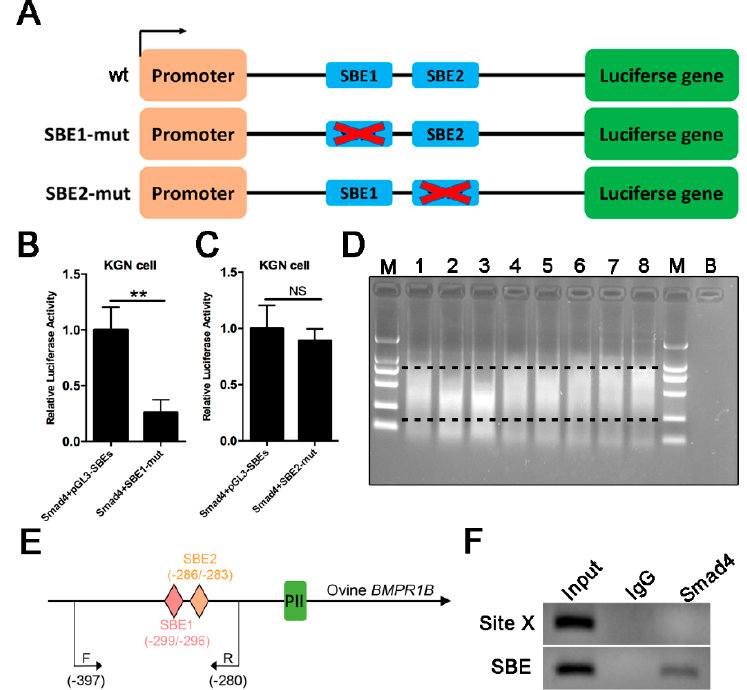
Figure 5. Smad4 directly binds to SBE motifs of the ovine BMPR1B promoter region. ( A ) The luciferase reporter construct of individual SBE motif-mutant type PII promoter. ( B , C ) Luciferase assay. SBE1 motif-mutant type ( B ) or SBE2 motif-mutant type ( C ) PII promoter reporter construct was co-transfected with pcDNA3.1-Smad4 into KGN cells, and luciferase activity was detected using a Dual-Luciferase Reporter Assay System. ( D ) Ultrasonic time optimization. ( E ) The location of primers used for ChIP assay. F indicates forward primer. R indicates reverse primer. ( F ) ChIP assay. Bars represent the mean ± SEM of at least three repeats. ** p < 0.01. ns, no significant.